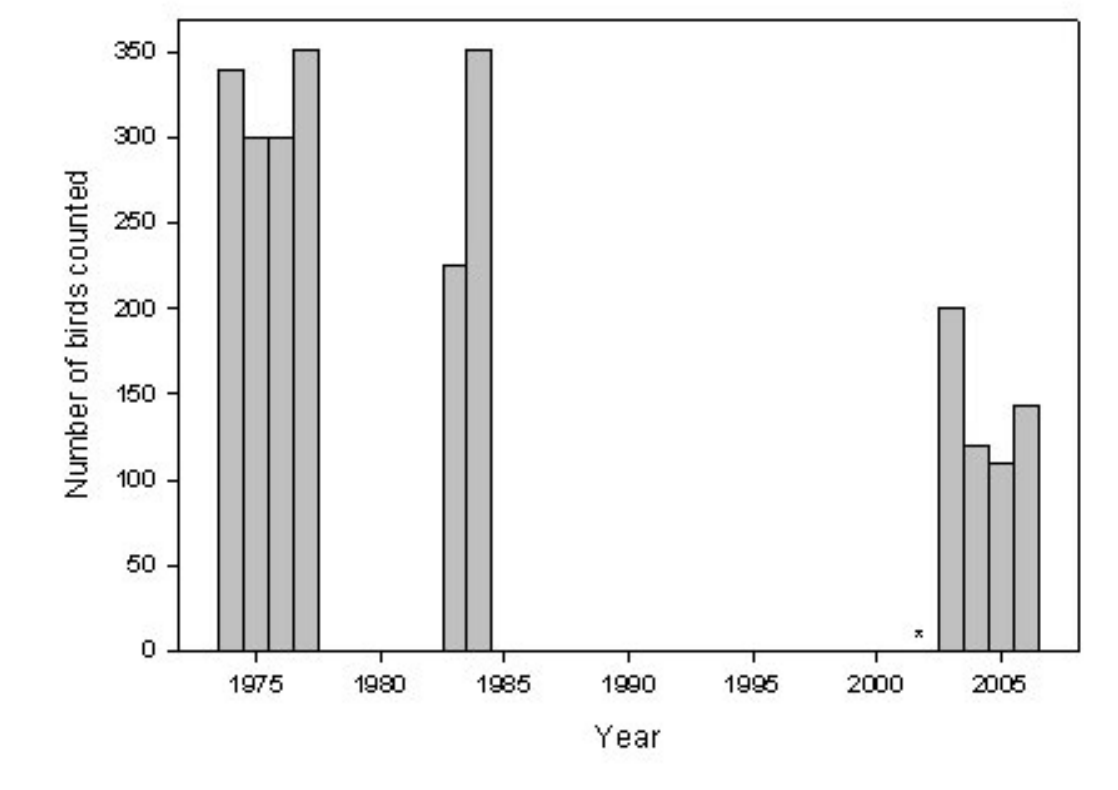
Fig. 5. Number of Ivory Gull individuals counted on Seymour Island between 1974 and 2006. The asterisk indicates that the colony was not occupied in 2002 and thus could not be